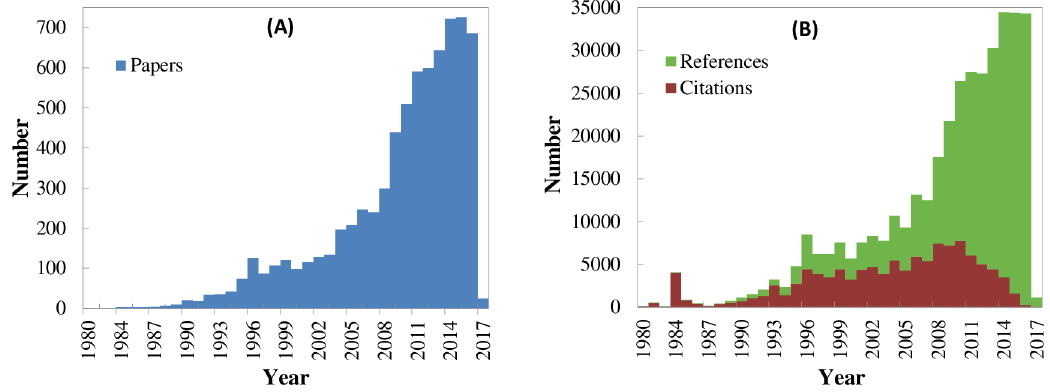
Fig 3. Basic statistics of DEA-related papers per year from 1980 to 2017. (A) Number of papers. (B) Number of citations and references of the papers.